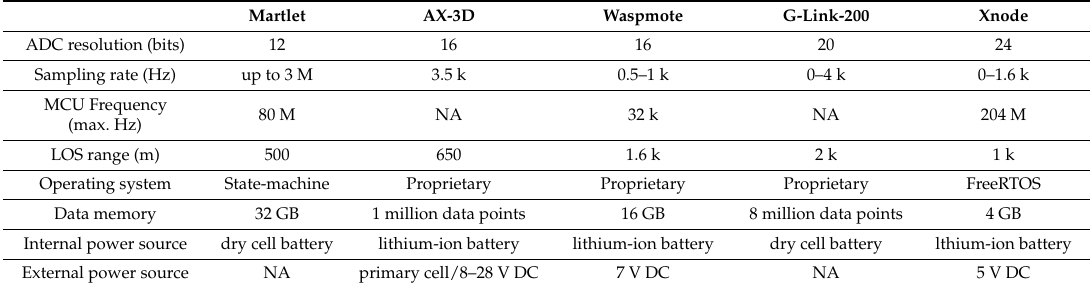
Table 2. Comparison of most advanced wireless sensor platforms in the market [30–34]*. Martlet